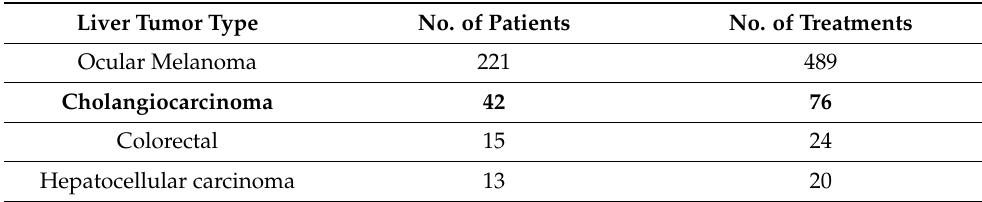
Table 2. EU experience with CS-PHP at December 2019. Total procedures performed in all cancers and in CCA are in bold. In particular, a total of 76 CS-PHP procedures were performed on 42 CCA patients mainly included in clinical trials or in standard